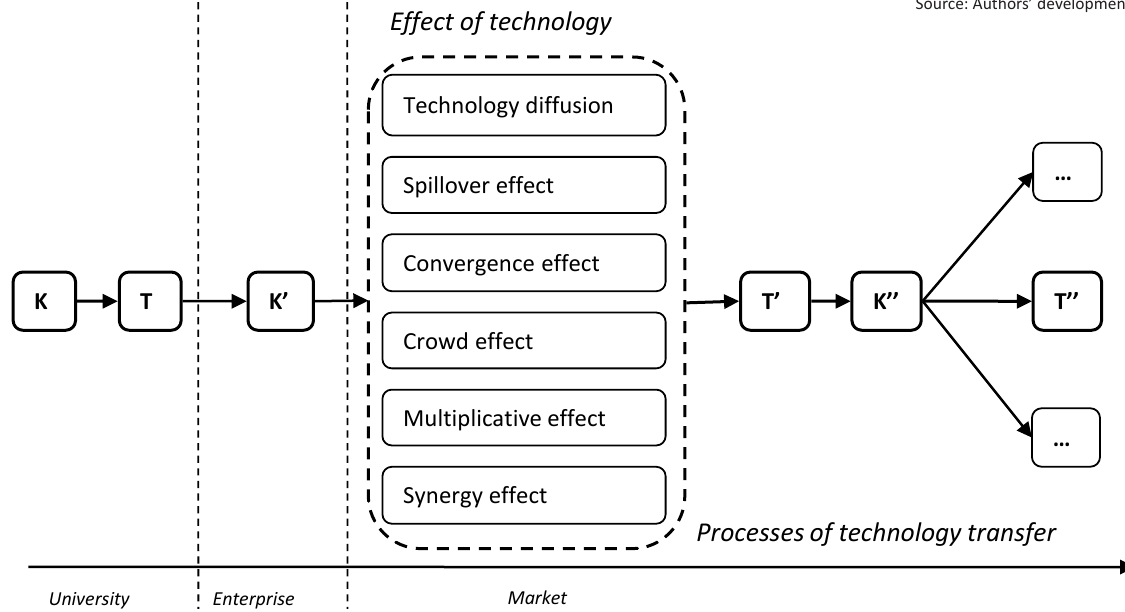
Figure 4. The emergence and effect of technology